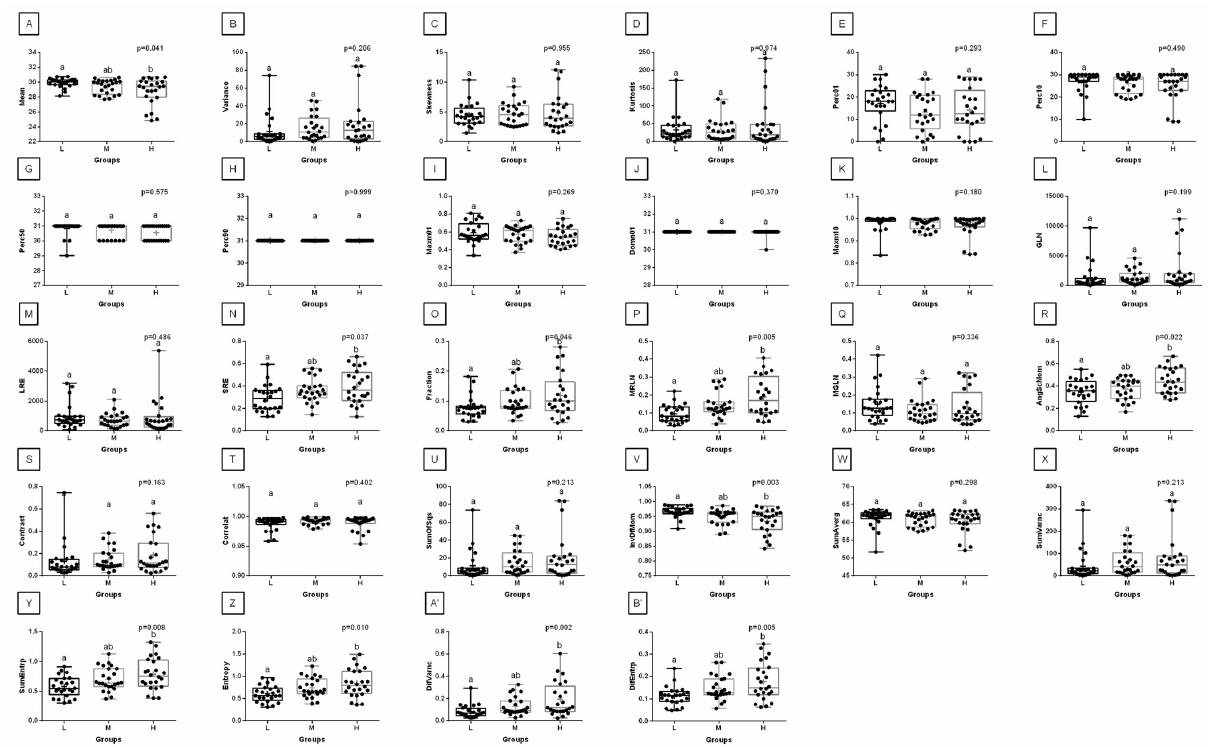
Figure 12. Analysis of texture features for the red component compared between light (L), moderate (M), and heavy (H) groups in the fourth region of interest (ROI 4). Differences between groups